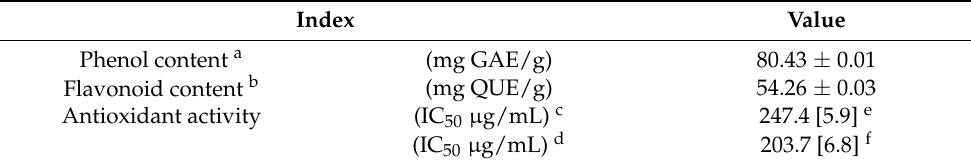
Table 1. Total phenol (TPC)/flavonoid (TFC) contents and antioxidant activity of DHE.